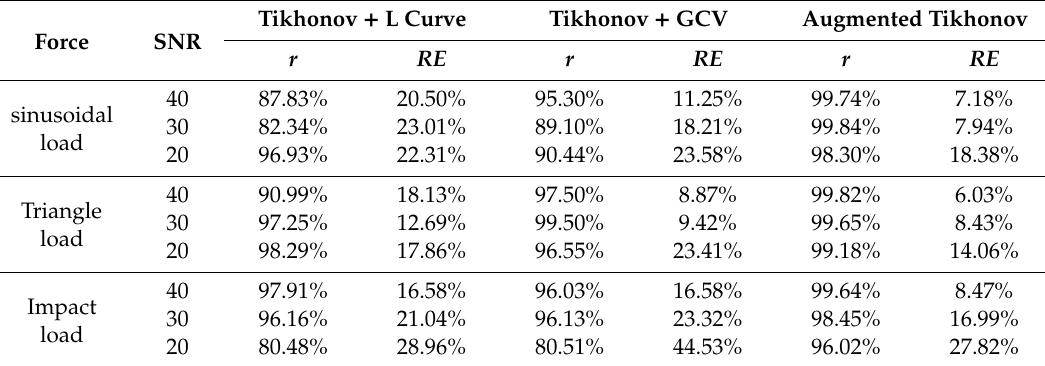
Figure 13. Identification result of impact load at SNR 20 dB: ( a ) Tikhonov method; ( b ) the proposed method.